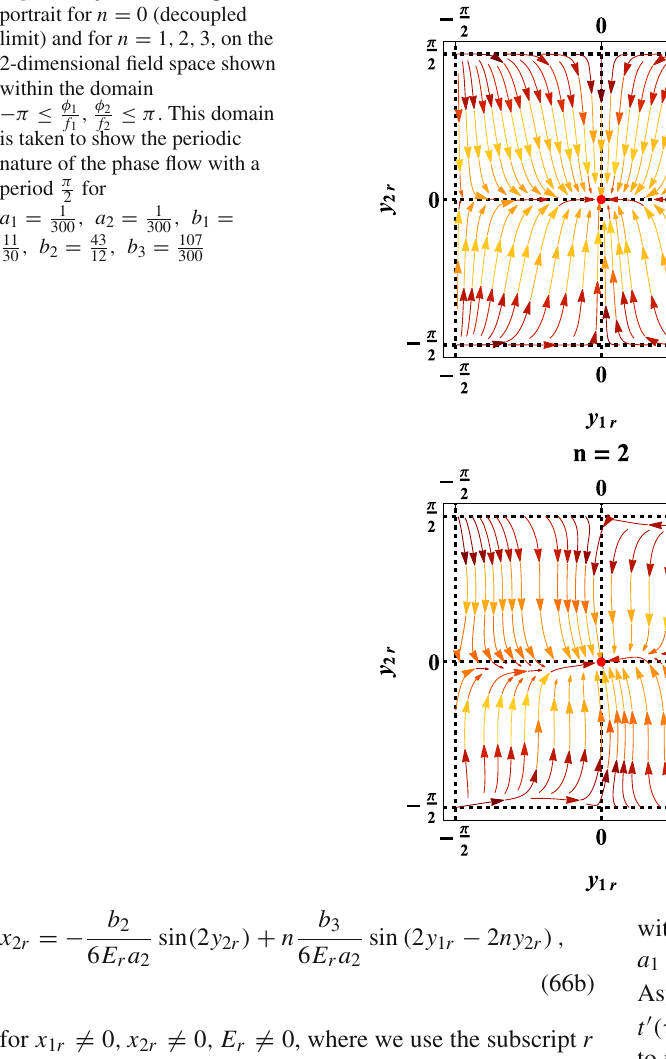
Fig. 4 Projection of the phase portrait for n = 0 (decoupled limit) and for n = 1 , 2 , 3, on the 2-dimensional field space shown within the domain − π ≤ φ 1 , φ 2 ≤ π . This domain f 1 f 2 is taken to show the periodic nature of the phase flow with a period π for 2 , a = 1 , b = a 1 = 1 2 1 300 300 , b = 43 , b = 107 11 2 3 30 12